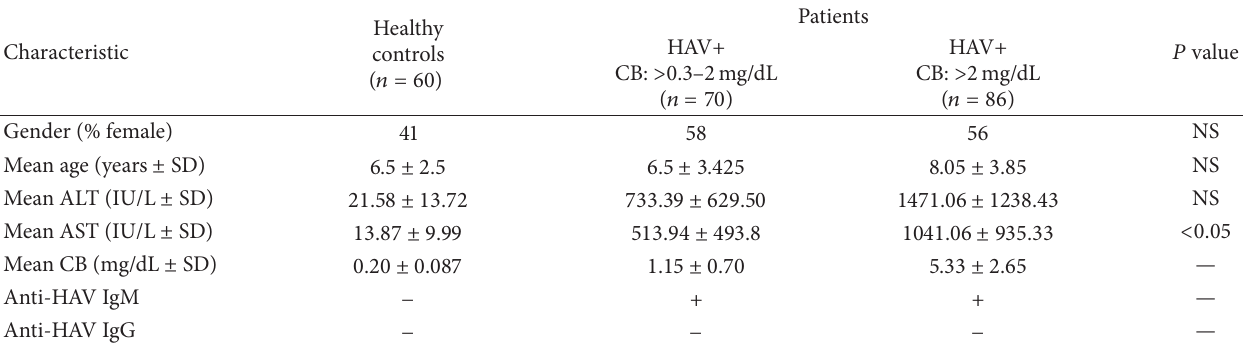
Table 1: Demographic and clinical characteristics of HAV-infected pediatric patients and